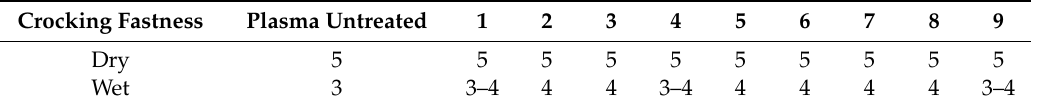
Table 4. Ratings of pigment dyed samples *.